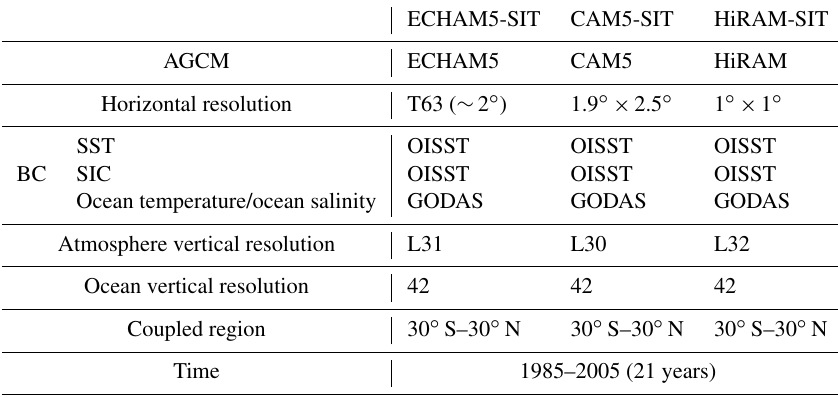
Table 1. Detailed information about the models and